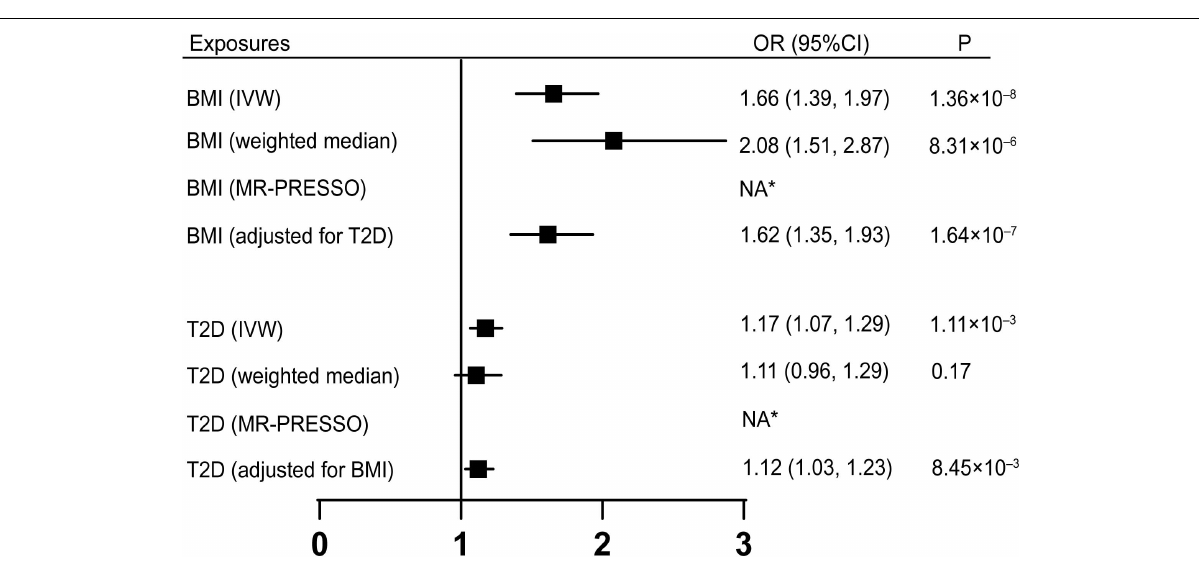
( Table 1 ). Likewise, the mediation effect of BMI was − 0.009 (95% CI, − 0.016, − 0.003) in T2D’s effect on CTS, with a mediation proportion of − 5.7% ( Table 1